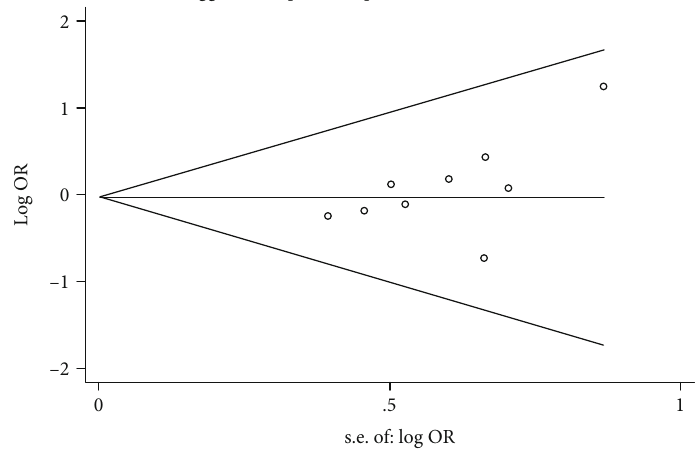
Figure 9: Begg ’ s funnel plot of circRNAs for esophageal cancer.